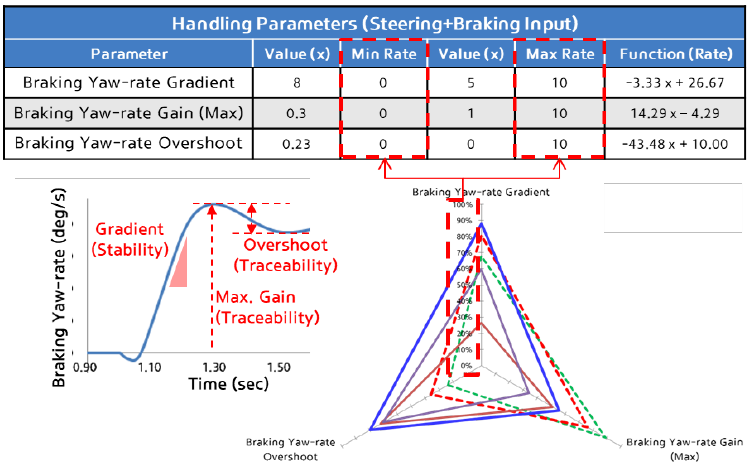
Figure 3. Additional settings for race-track-driving performance indicators.